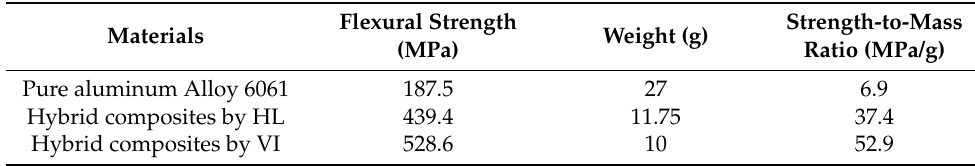
Table 2. Strength to mass ratio of